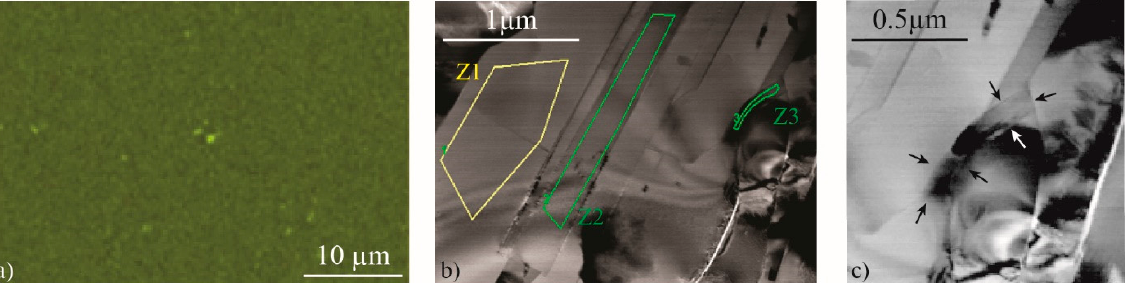
Figure 2. Study by SEM and TEM of the repartition of the Si atoms in the microstructure of the TNM + alloy densified at 1325 °C and within a silicide. ( a ) Si map by SEM of a large area; ( b ) delimitation of the three zones which were analysed (Table 4) and ( c ) TEM image of a ξ silicide precipitate. Table 4. Quantitative elemental analysis of the TNM + alloy densified at 1325 °C by EDS-TEM at the local scale of three zones which are surrounded in colour in Figure 2b. The values are given in at.% and the accuracy of these measurement is within 0.2.